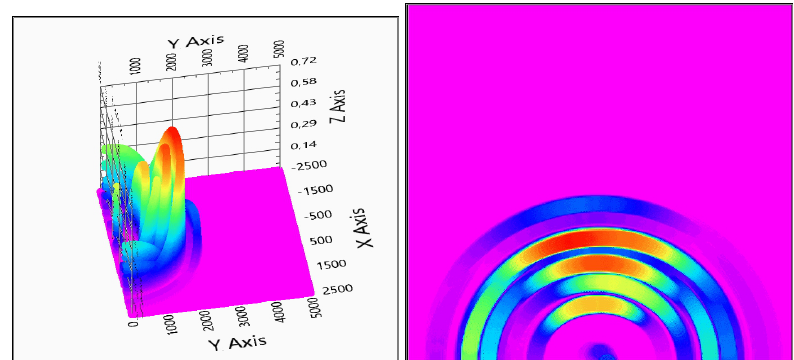
Figure 21. Evaluation of indoor test No. 3 (3 receivers). In the right column, the top view is also shown ( x , y : x , y space axis, z -axis: probability of solid object in x , y defined